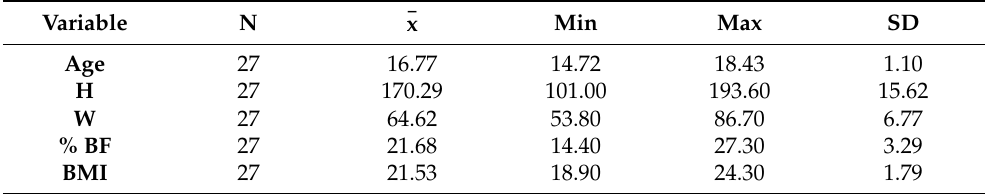
Table 1. Descriptive statistics of the basic anthropometric and morphological characteristics of the